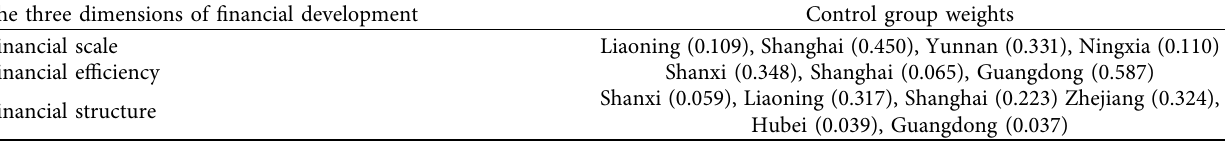
Table 3: Synthetic BTH region: control group